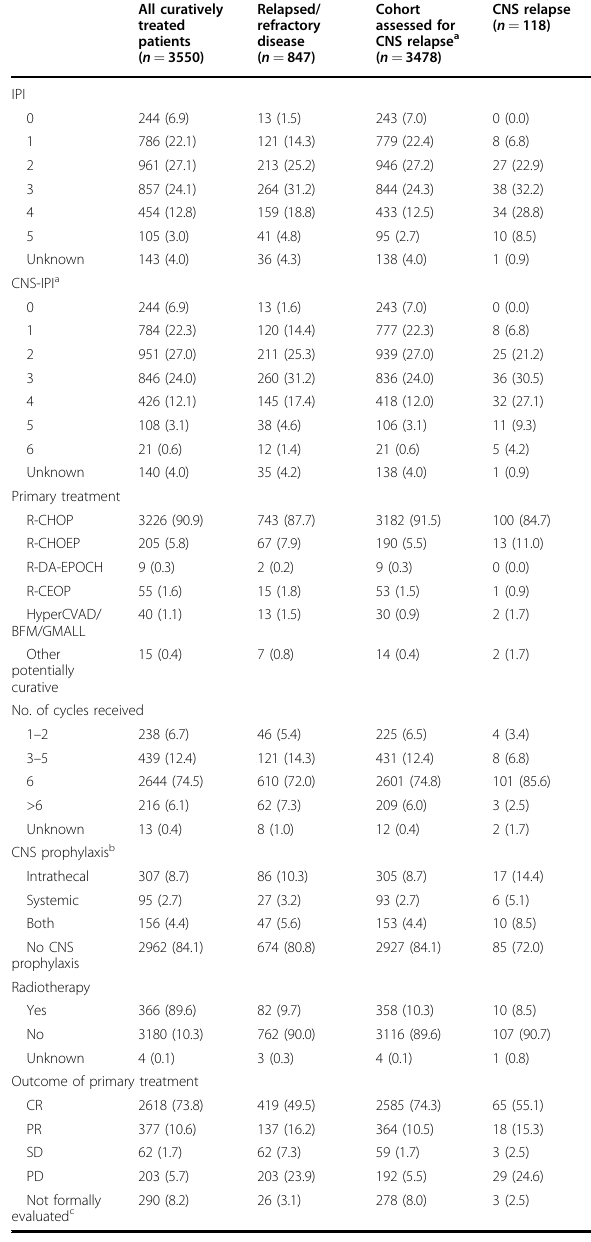
Table 2 International prognostic index (IPI), CNS-IPI, fi rst- line treatment and treatment response in all DLBCL patients treated with curative intent, and patients who experienced relapsed/refractory disease during follow-up (CNS progression/relapse presented